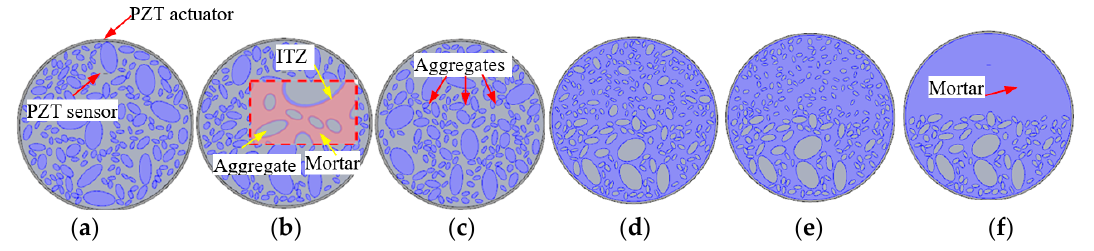
Figure 2. Circular concrete-filled steel tubulars (CCFST) meso-scale models with random numerical aggregates and segregation. ( a ) Sample 1; ( b ) Sample 2; ( c ) Sample 3; ( d ) Coarse aggregates segregation; ( e ) Coarse and middle aggregates segregation; ( f ) All aggregates segregation.